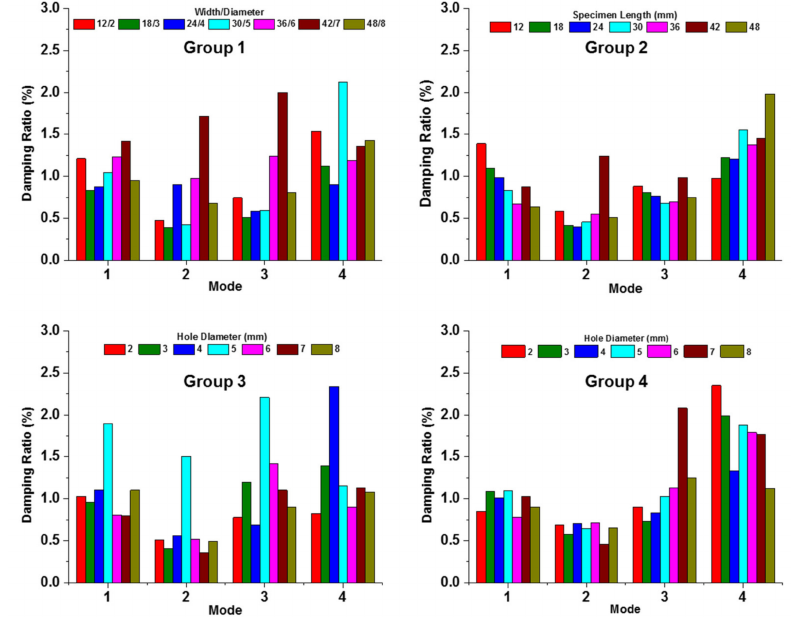
Figure 11. Damping ratio plots for all specimen groups and frequency